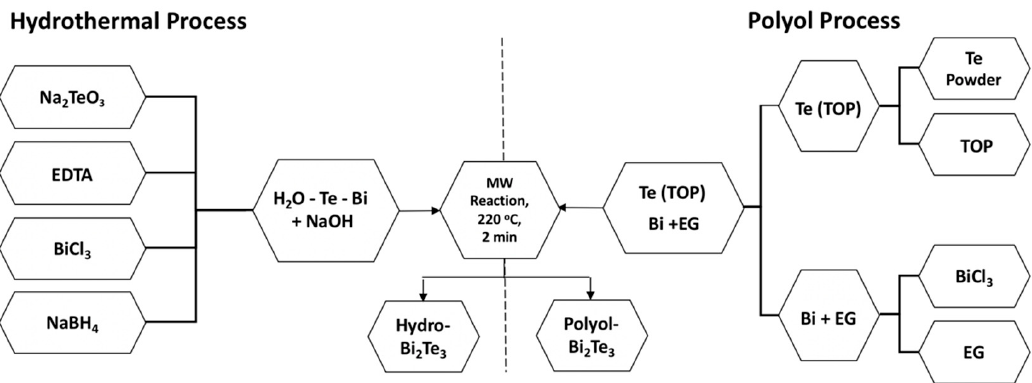
Figure 1. Schematic of the MW-assisted hydrothermal, and polyol synthesis